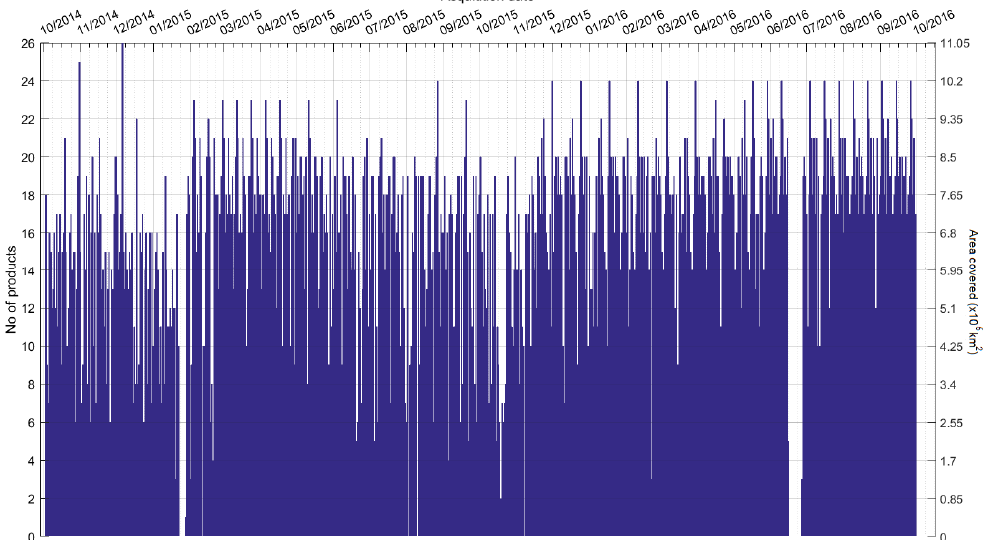
Figure 6. Daily number of Sentinel-1A acquisitions used in this study and area covered. The gaps indicate periods of satellite unavailability. Average image area: 250 × 170 km 2 .